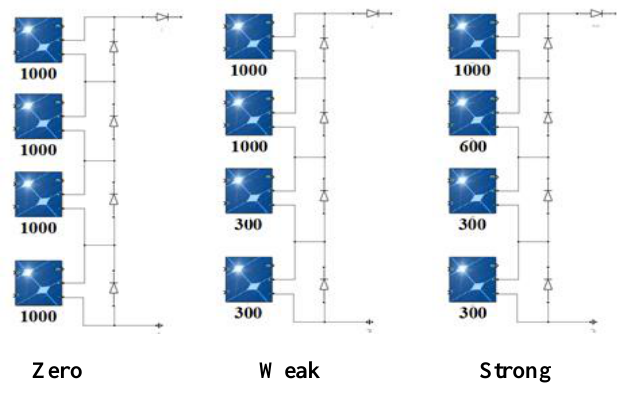
Fig. 7. An array of four modules with Zero, Weak, and Strong partial shading conditions